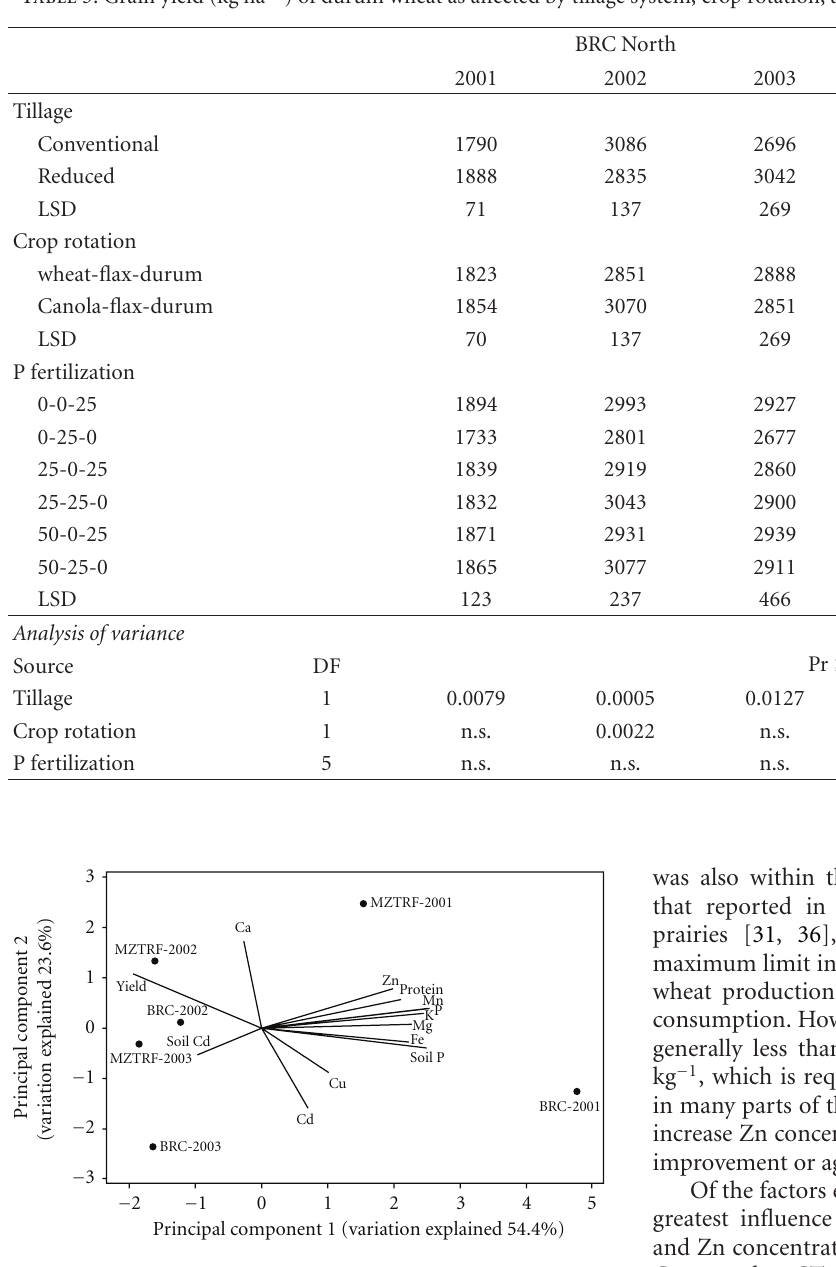
Figure 1: Principal component analysis (based on correlation mat- rix) of grain yield, grain concentrations of Cd, Zn, Cu, Fe, Mg, K, P, Mn, Ca, grain protein concentration, and selected soil properties (soil P and soil Cd) across 6 site-years. Biplot vectors are trait factor loadings for principal component 1 (PC1) and PC2. Data at each site-year are averaged across P fertilizer